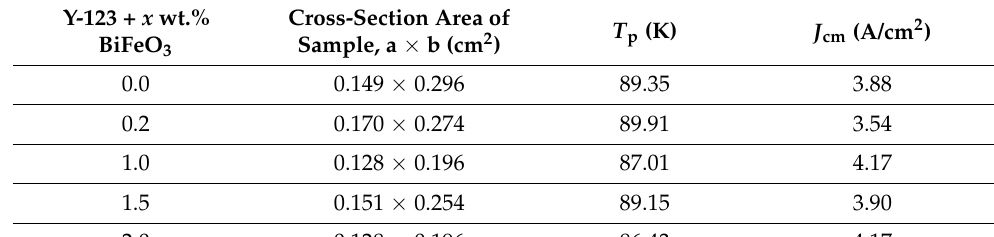
Table 4. The cross-section area of a sample with the coupling peak temperature T p and intergranular critical current density J cm for the Y-123 + x wt.% of BiFeO 3 . Cross-Section Area of Y-123 + x wt.% T p (K) J cm (A/cm 2 ) Sample, a × b (cm 2 ) BiFeO 3